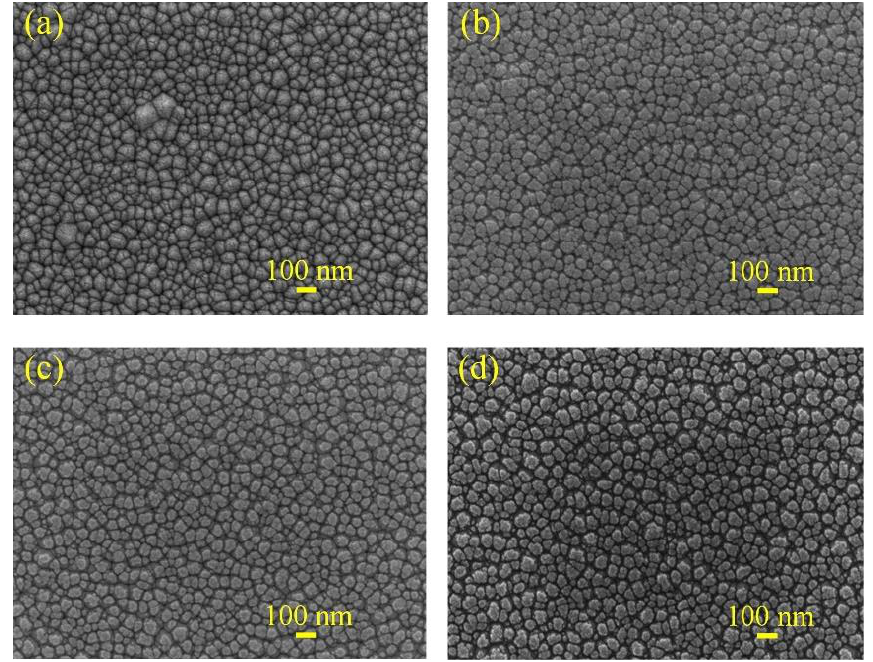
Figure 6. The surface morphologies of as-deposited ( a ) and RTA treated (( b ) 5 min, ( c ) 10 min and ( d ) 15 min) ZnO thin films at 400 °C.